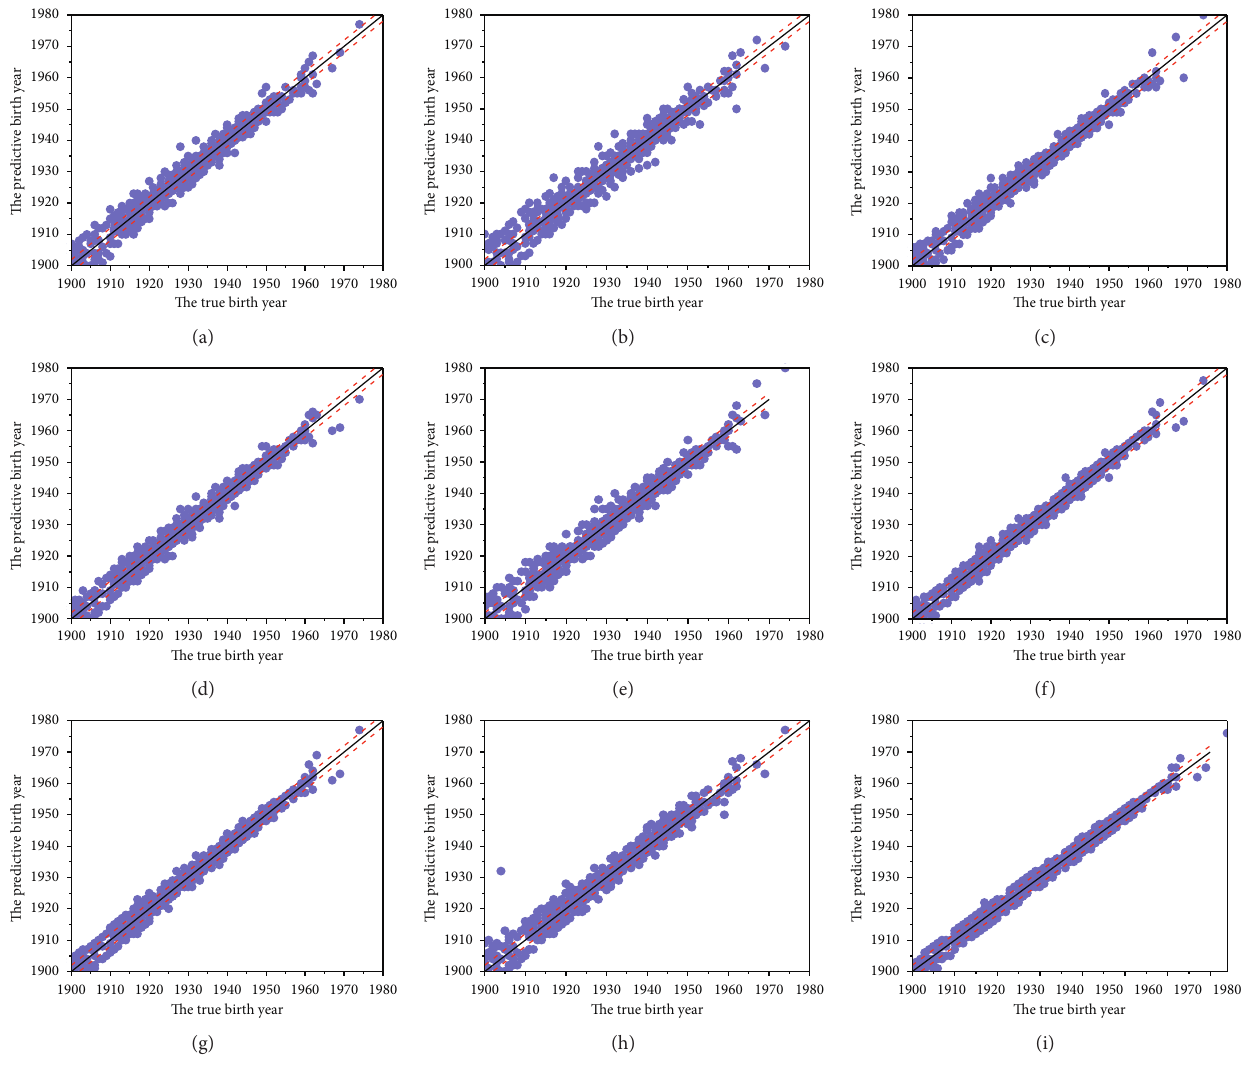
Figure 2: Prediction results by SVR, GBDT, and XGBoost. (a) SVR S . (b) SVR C . (c) SVR SC . (d) GBDT S . (e) GBDT C . (f) GBDT SC . (g) XGBoost. (h) XGBoost C . (i) XGBoost SC . Table 4: Prediction results of each